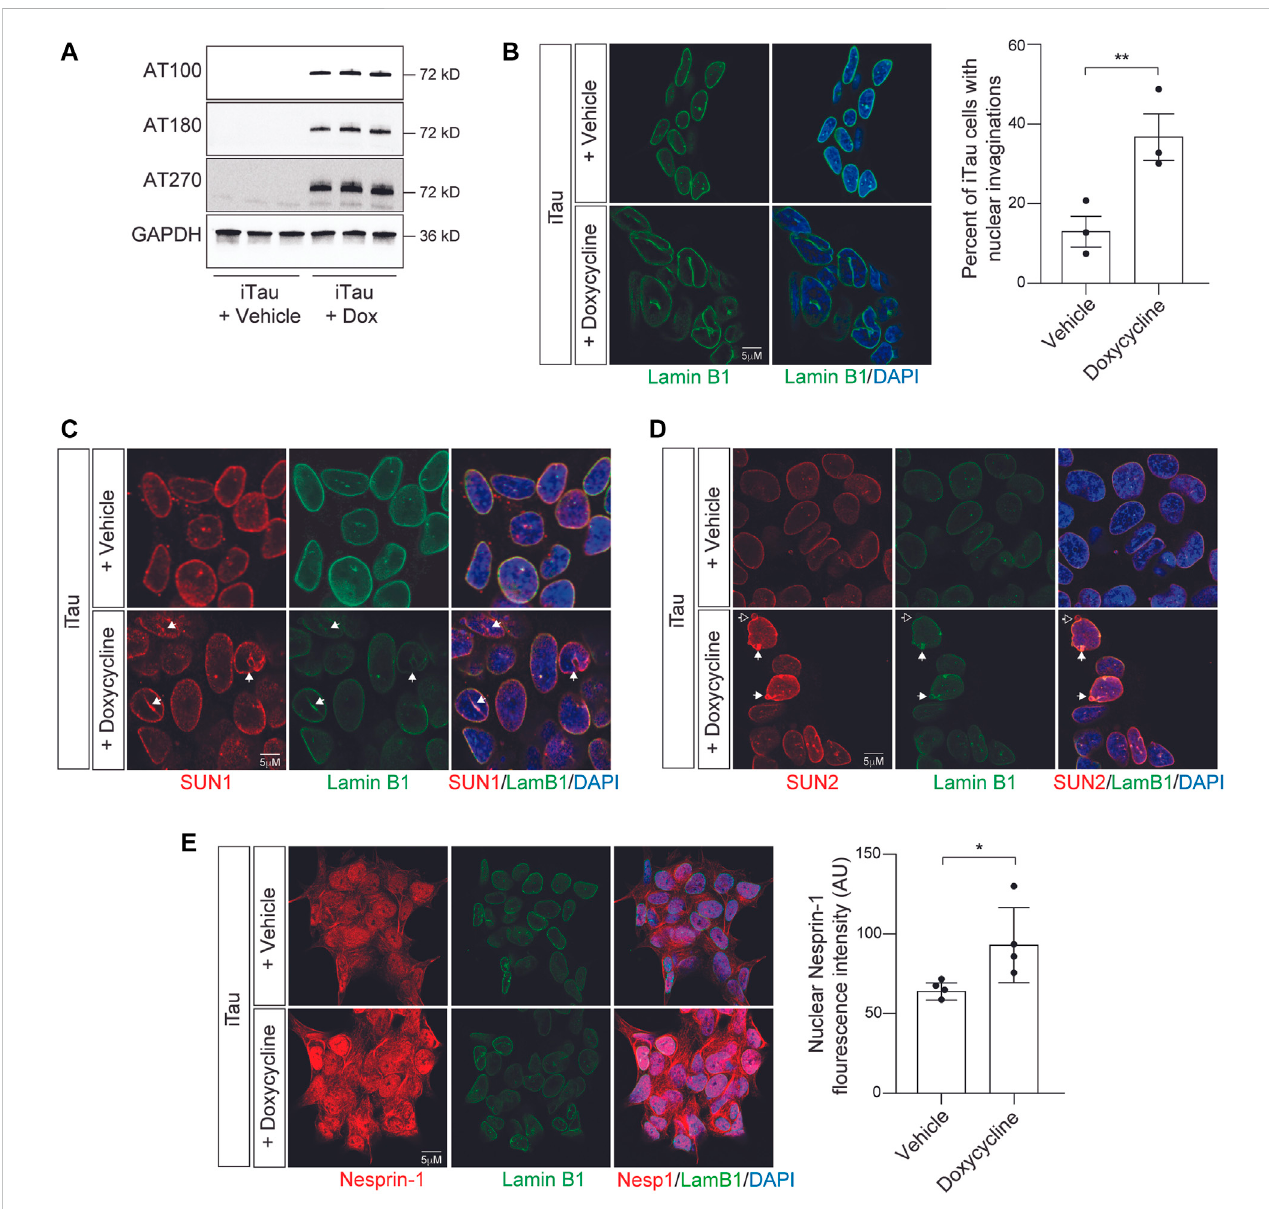
FIGURE 2 Induction of pathogenic forms of tau in iTau cells causes nuclear envelope invaginations and redistribution of LINC complex components. (A) Detection of disease-associated tau phosphoepitopes in iTau cells upon treatment with doxycycline based on Western blotting. (B) 24-h doxycycline-mediated induction of tau expression causes a signi fi cant increase in nuclear envelope invaginations compared to vehicle treated control based on lamin B1 immuno fl uorescence. (C) Relationship of SUN1 (C) and SUN2 (D) with nuclear invaginations and blebs upon doxycycline-mediated induction of tau expression in iTau cells. The empty arrow in (D) indicates presence of SUN2 in a nuclear bleb lacking lamin. (E) Doxycyline-mediated induction of tau expression in iTau cells causes a signi fi cant increase of nuclear Nesprin-1 based on immuno fl uorescence. n = 3 replicates per group, t -test, * p < 0.05, ** p < 0.01. Error bars indicate